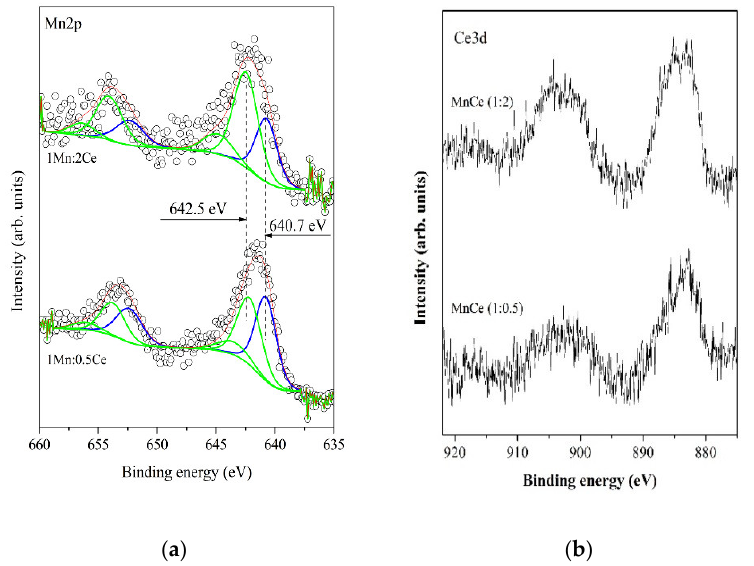
Figure 8. Fitted Mn2p ( a ) and Ce3d ( b ) photoelectron peaks of the Ce and Mn–Ce samples after reaction.